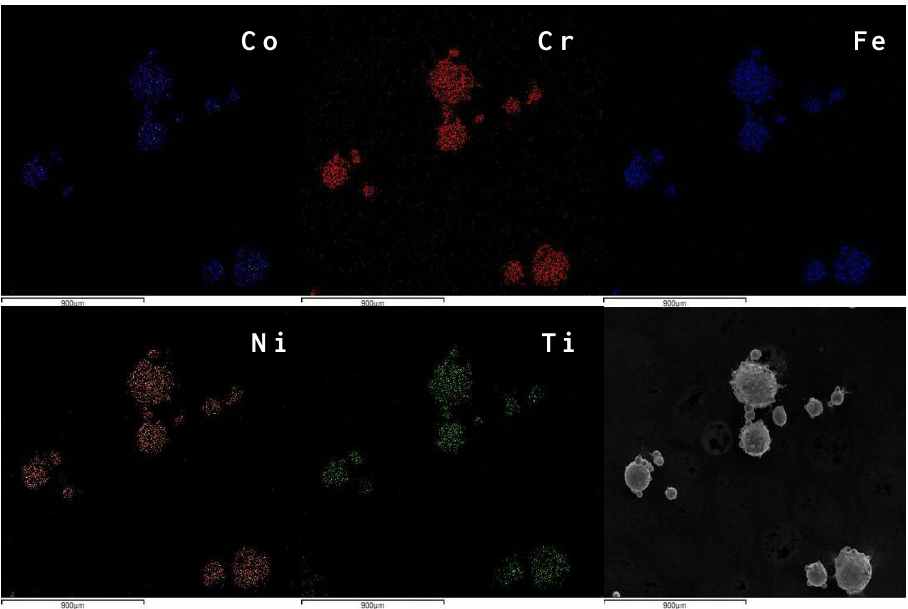
Figure 1. Element distribution of CoCrFeNiTi 0.5 high entropy alloys (HEA) power.